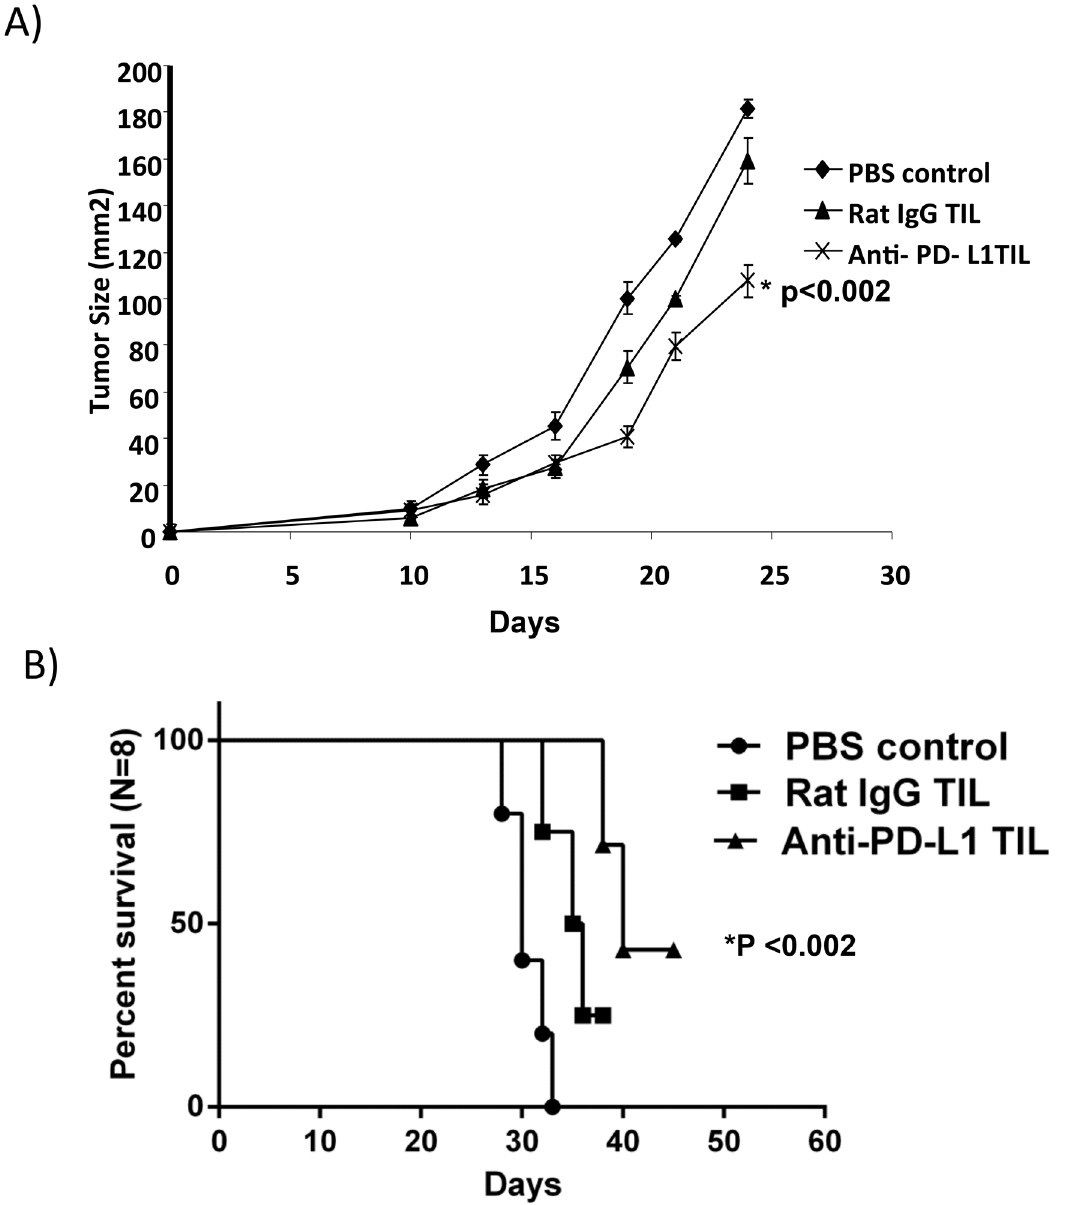
Fig 5. PD-L1 blockade improves the anti-tumor efficacy of TIL in vivo . A) Mice received MC-38 tumor cells on day 0 followed by 600 rad TBI on day 3. TIL isolated from NrIgG or anti-PD-L1 antibody treated mice (n = 8) were cultured with 3000IU/ml of IL-2 for 5 days and adoptively transferred on day 4